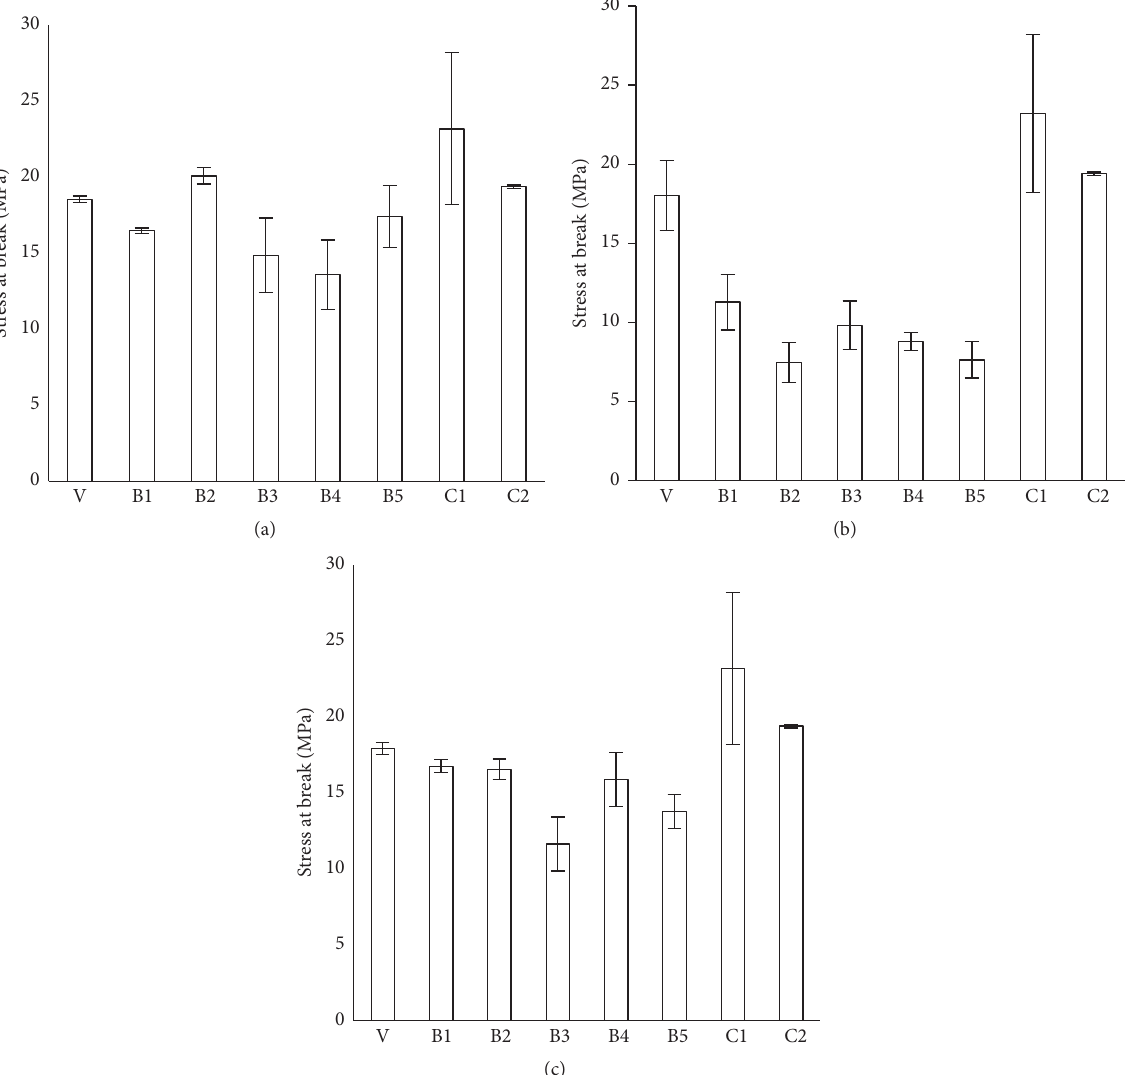
Figure 2: Stress at break (MPa) measured for the studied materials in comparison to the commercial grade products. Die Head Temperature (DHT) = (a) 175 ∘ C, (b) 185 ∘ C, and (c) 195 ∘